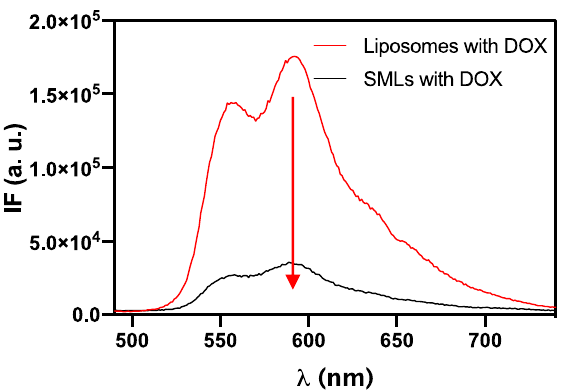
Figure 11. Fluorescence spectra ( λ exc = 480 nm) of doxorubicin (2 × 10 − 6 M) in liposomes (without magnetic nanoparticles) and in SMLs containing Ca 0.25 Mg 0.75 Fe 2 O 4 magnetic nanoparticles. Table 4. Steady-state fluorescence anisotropy ( r ) values for doxorubicin in SMLs with different lipid formulations, in SMLs upon interaction with GUVs and in GUVs (for comparison). Total lipid concentration: 1 × 10 − 3 M; DOX: 2 × 10 − 6 M. Nanosystem Lipid